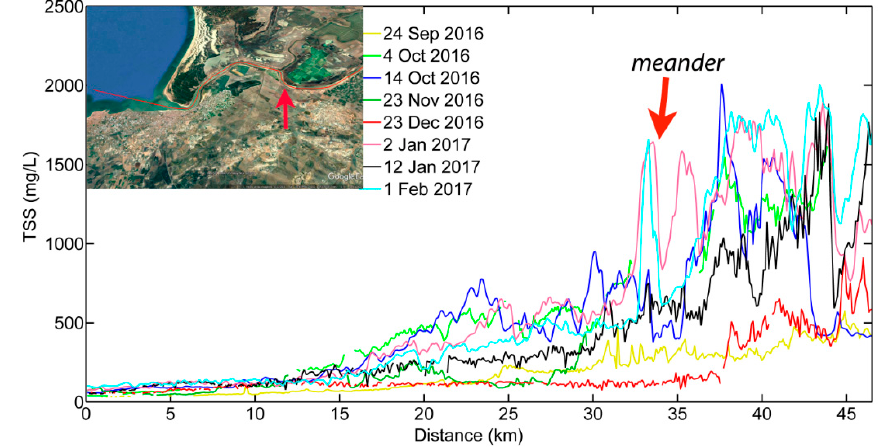
Figure 11. Sentinel-2 derived Total Suspended Solids (TSS, mg/L) concentration in the longitudinal transect of the first 47 km of the Guadalquivir estuary (24 September 2016–1 February 2017). All the images were corrected with ACOLITE. Red line on the map indicates the start at the mouth and the end upstream of the longitudinal transect. The meander with a sinuous curve located at Brazo de la Torre is indicated on the map with the red arrow.